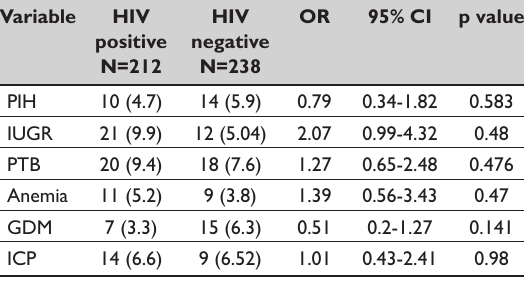
Table 2: Comparison of obstetric complications